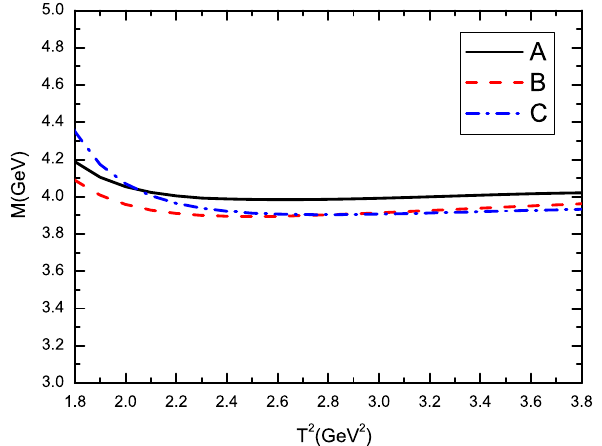
Fig. 6 The masses of the axialvector tetraquark states with variations of theBorelparameter T 2 forthe energyscale μ = 1 . 3GeV andcontin- √ s 0 = 4 . 45GeV, where A , B and C denote uum threshold parameter the C γ μ ⊗ γ ν C type tetraquark state c ¯ cu ¯ d , C γ μ ⊗ γ 5 C type